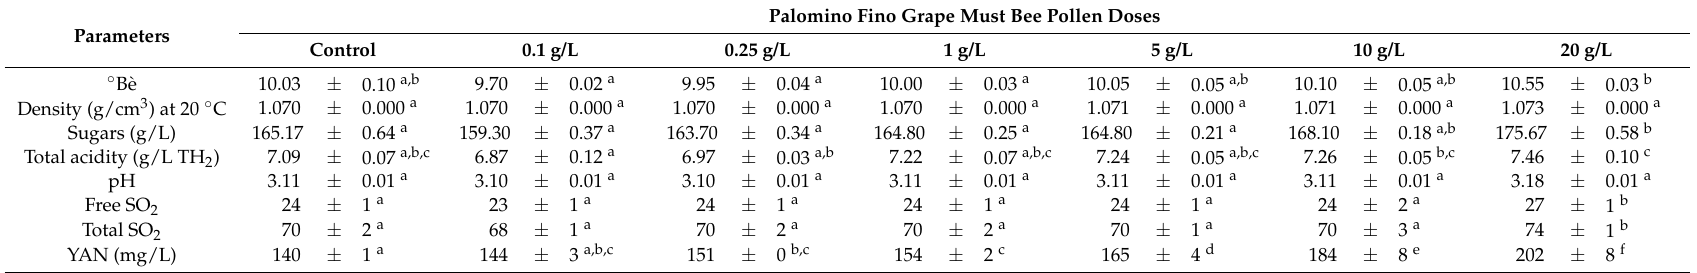
Table 1. Physico-chemical parameters of Palomino fino grape must with addition of bee pollen (0.1, 0.25, 1, 5, 10 and 20 g/L) and control.